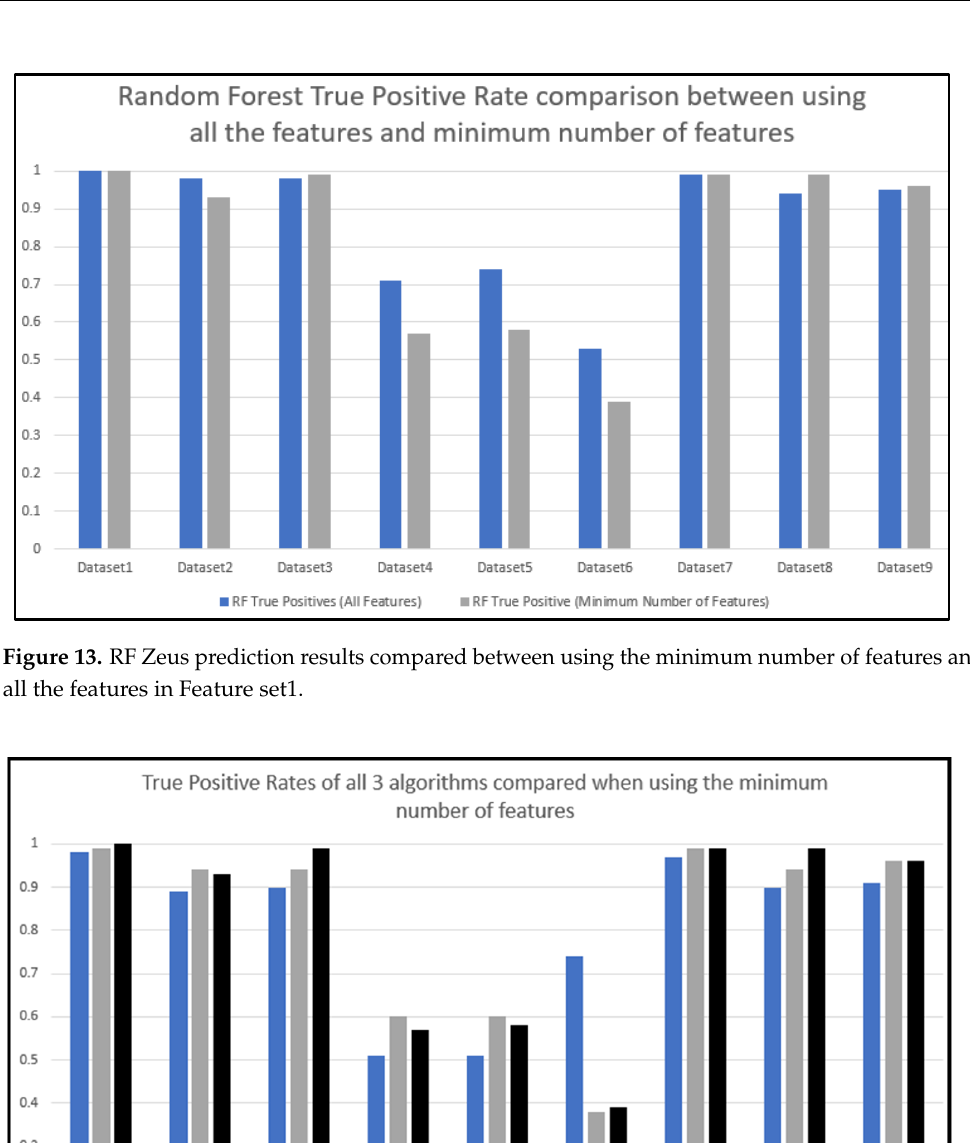
Figure 14. True positive rates compared for all three algorithms when using the minimum number of features.